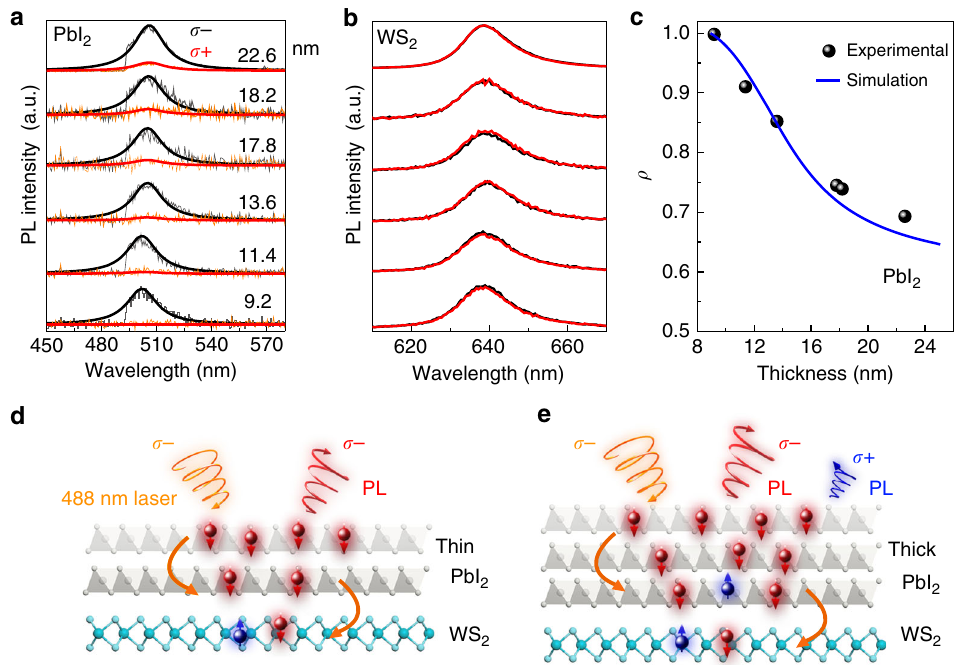
Fig. 2 Thickness-dependent spin polarization and the underlying mechanism in PbI 2 /WS 2 heterostructures. a , b Circularly polarized PL spectra of PbI 2 and WS 2 in PbI 2 /WS 2 heterostructures with different thicknesses. c Degree of polarization ρ of PbI 2 as a function of thickness of the heterostructures. The solid line represents the numerical simulation result. d , e Schematic illustrations of the resulting spin polarization in the thin and thick PbI 2 /WS 2 heterostructures. The curled curves represent the incident light and the PL emissions. The red balls represent spin-down electrons, and the blue balls represent spin-up electrons.